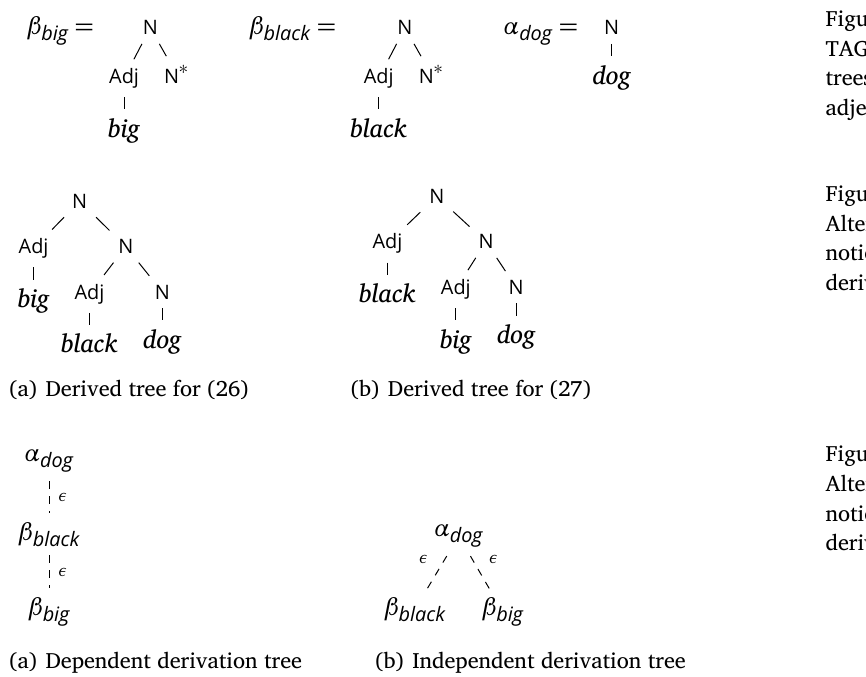
Figure 23: TAG elementary trees for adjectives